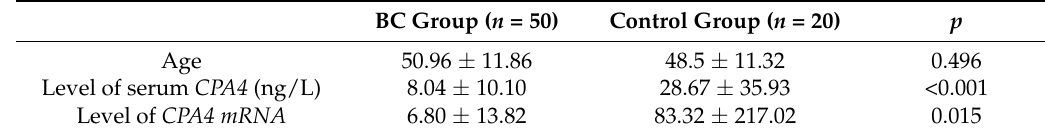
Table 2. Comparison of the two groups.